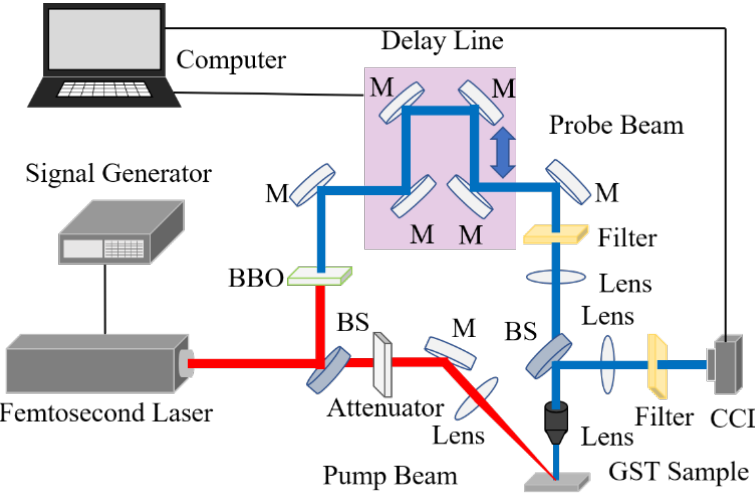
Figure 1. Schematic of the reflective-type pump-probe system.